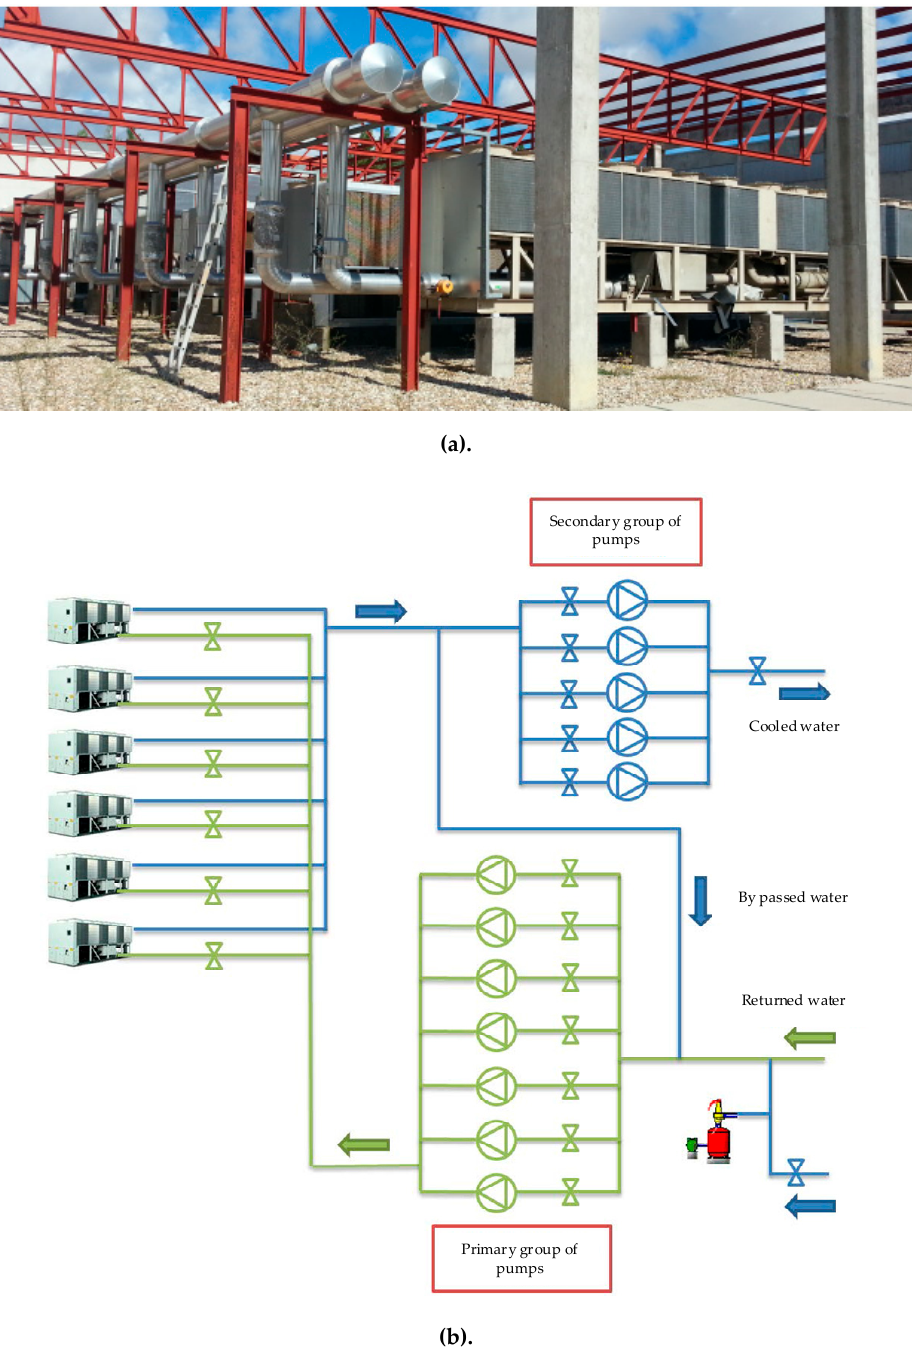
Figure 1. ( a ) Chiller plant at the roof of the hospital; ( b ) Scheme of Figure 1 . ( a ) Chiller plant at the roof of the hospital; ( b ) Scheme of principle.